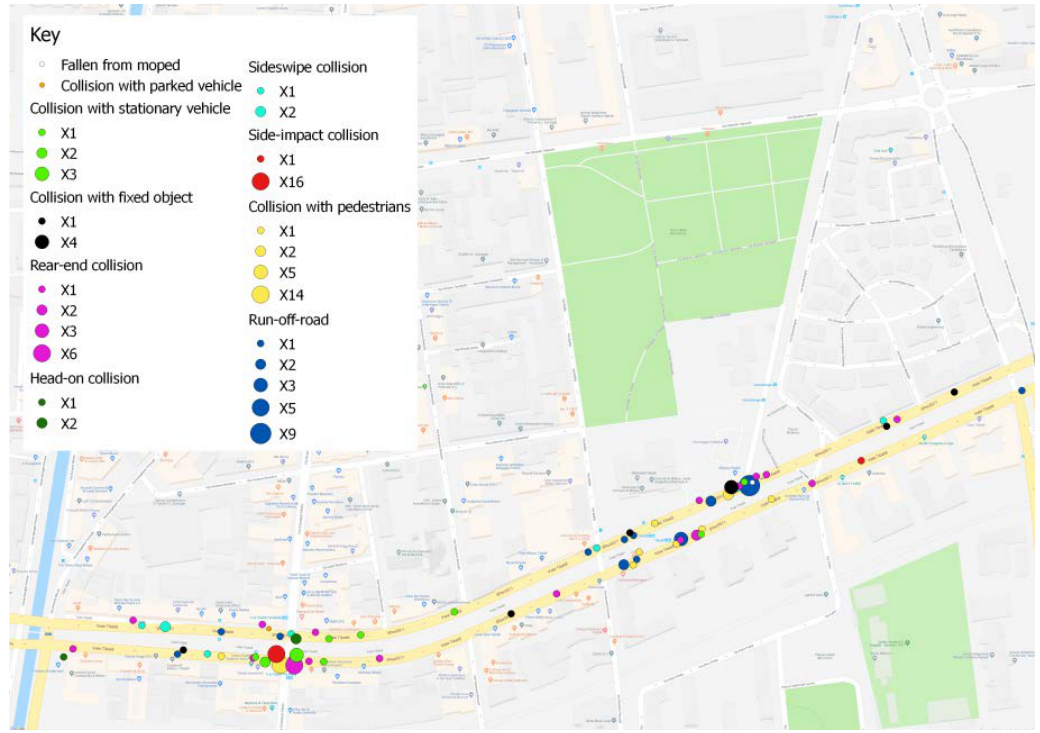
Figure 4. Example of analysis and location of traffic accidents and subdivision by type (QGIS elaboration of Google Maps).